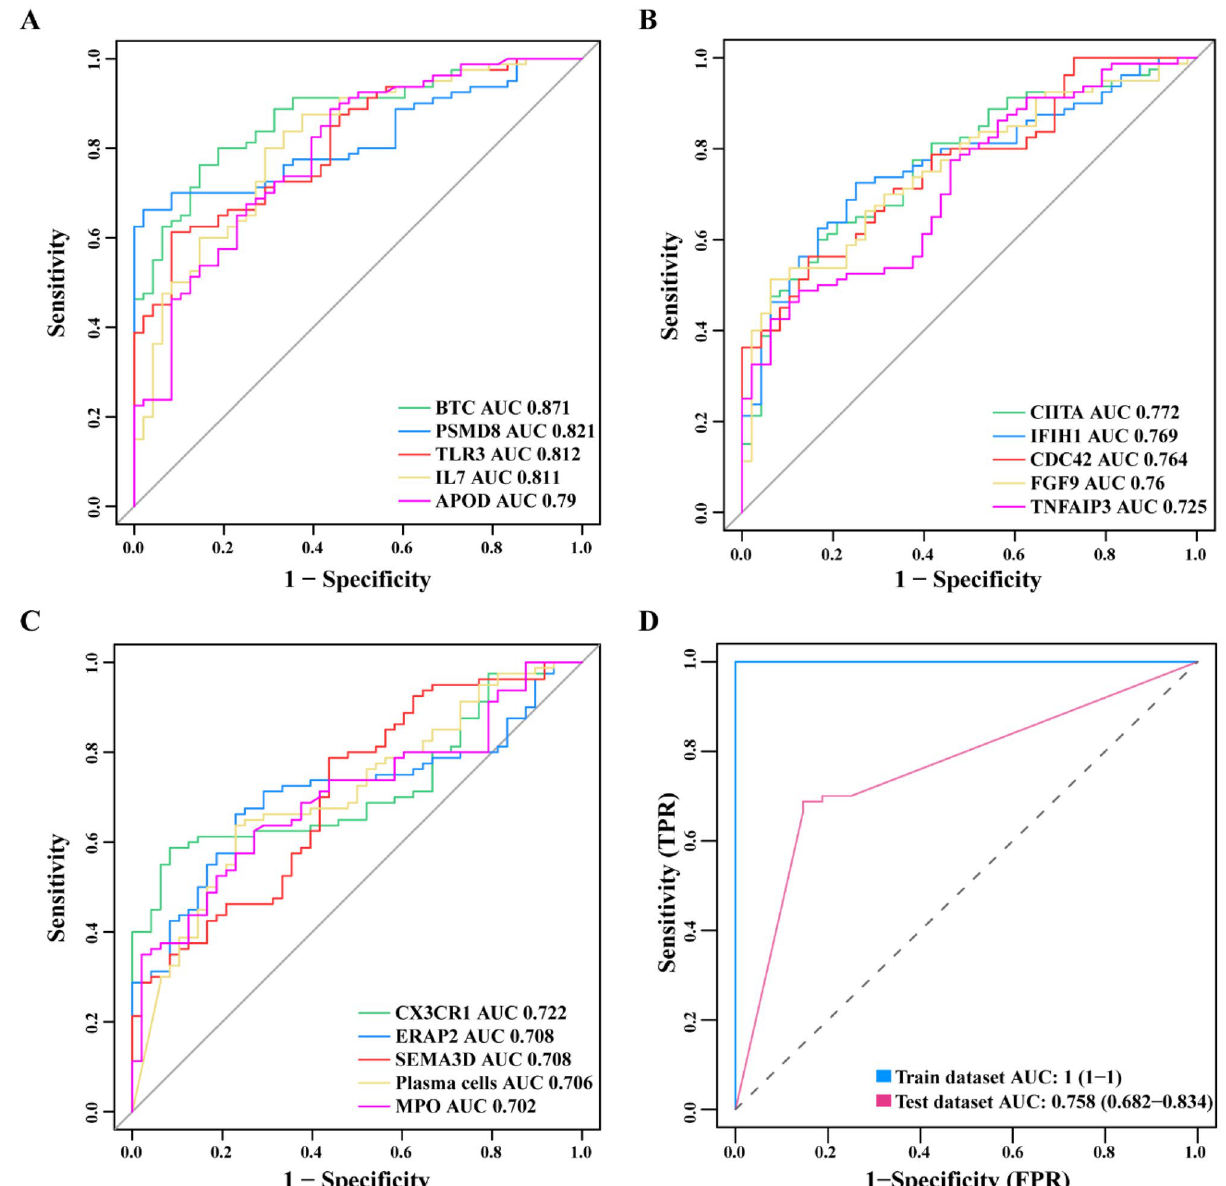
Figure 8. Verification of biomarkers. ( A – C ) Validation of the diagnostic efficacy of 15 biomarkers in the validation set; ( D ) validation of diagnostic efficacy after fitting 15 biomarkers into one